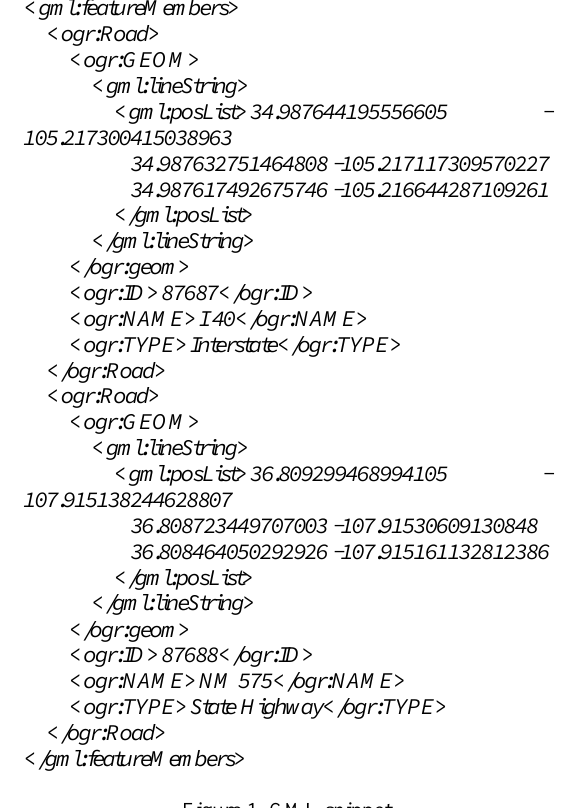
Figure 2. Compression model